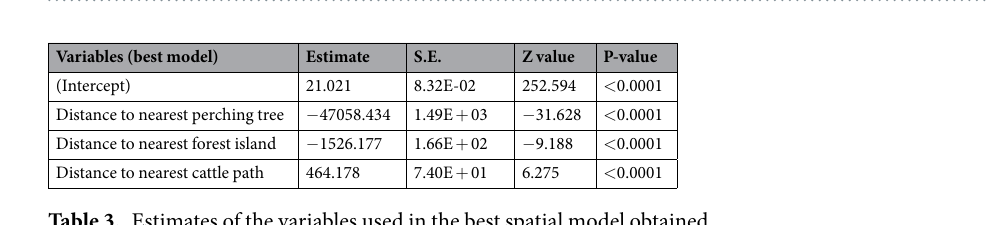
Table 3. Estimates of the variables used in the best spatial model